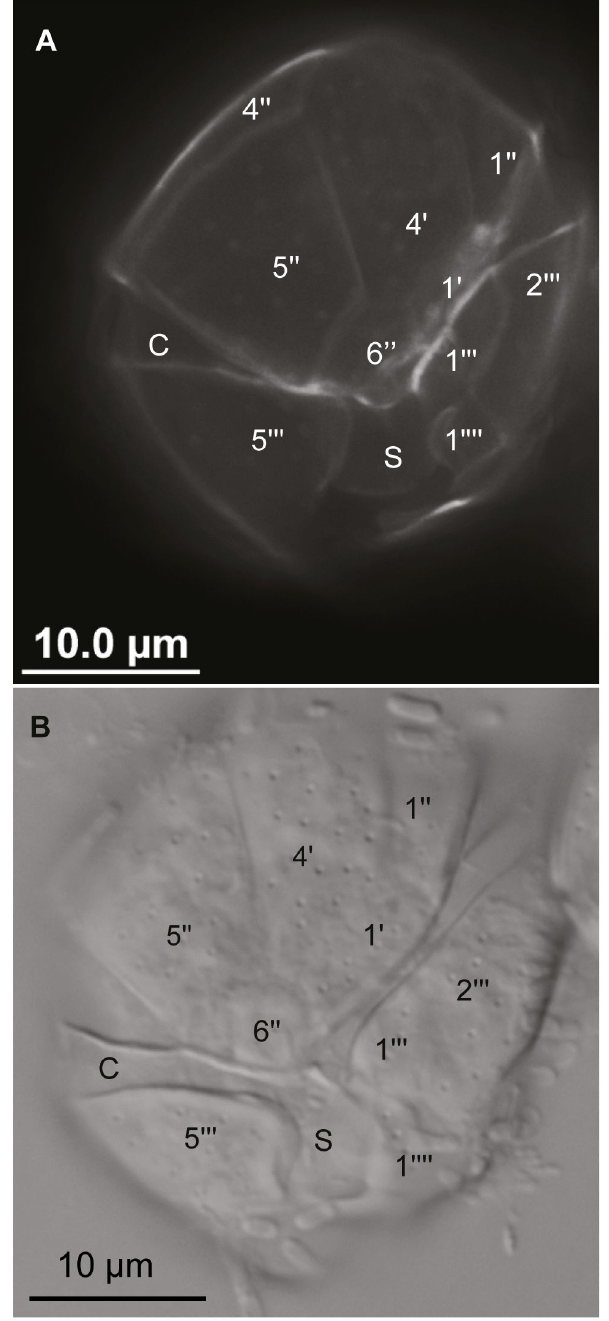
Figure 5. Calcofluor white epifluorescence micrograph (A) and differential interference light micrograph (B) of NQAIF103 showing ventral plate configuration. doi: 10.1371/journal.pone.0079278.g005 spherical when observed in antapical / apical and dorso / ventral views. Cells are 33 to 42 µm long (average: 39.04±2.94 µm, n = 12), 33 to 40 µm wide (average: 38.32±3.34 µm, n = 11) and 35 to 42 µm thick (thickness measured as the length of